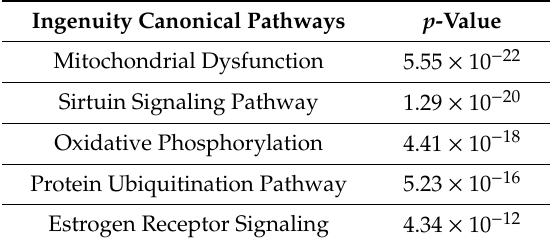
Table 2. Functional enrichment analysis of the di ff erentially expressed genes in H1975 cells treated with HGK at 50 µ M.